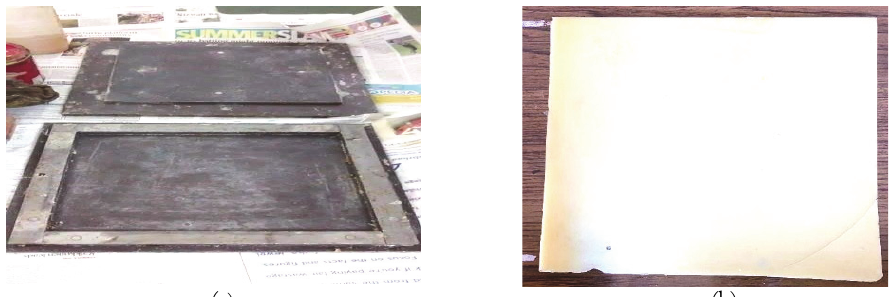
Figure 1: (a) Molds used for composite sheet preparation (b) Prepared epoxy